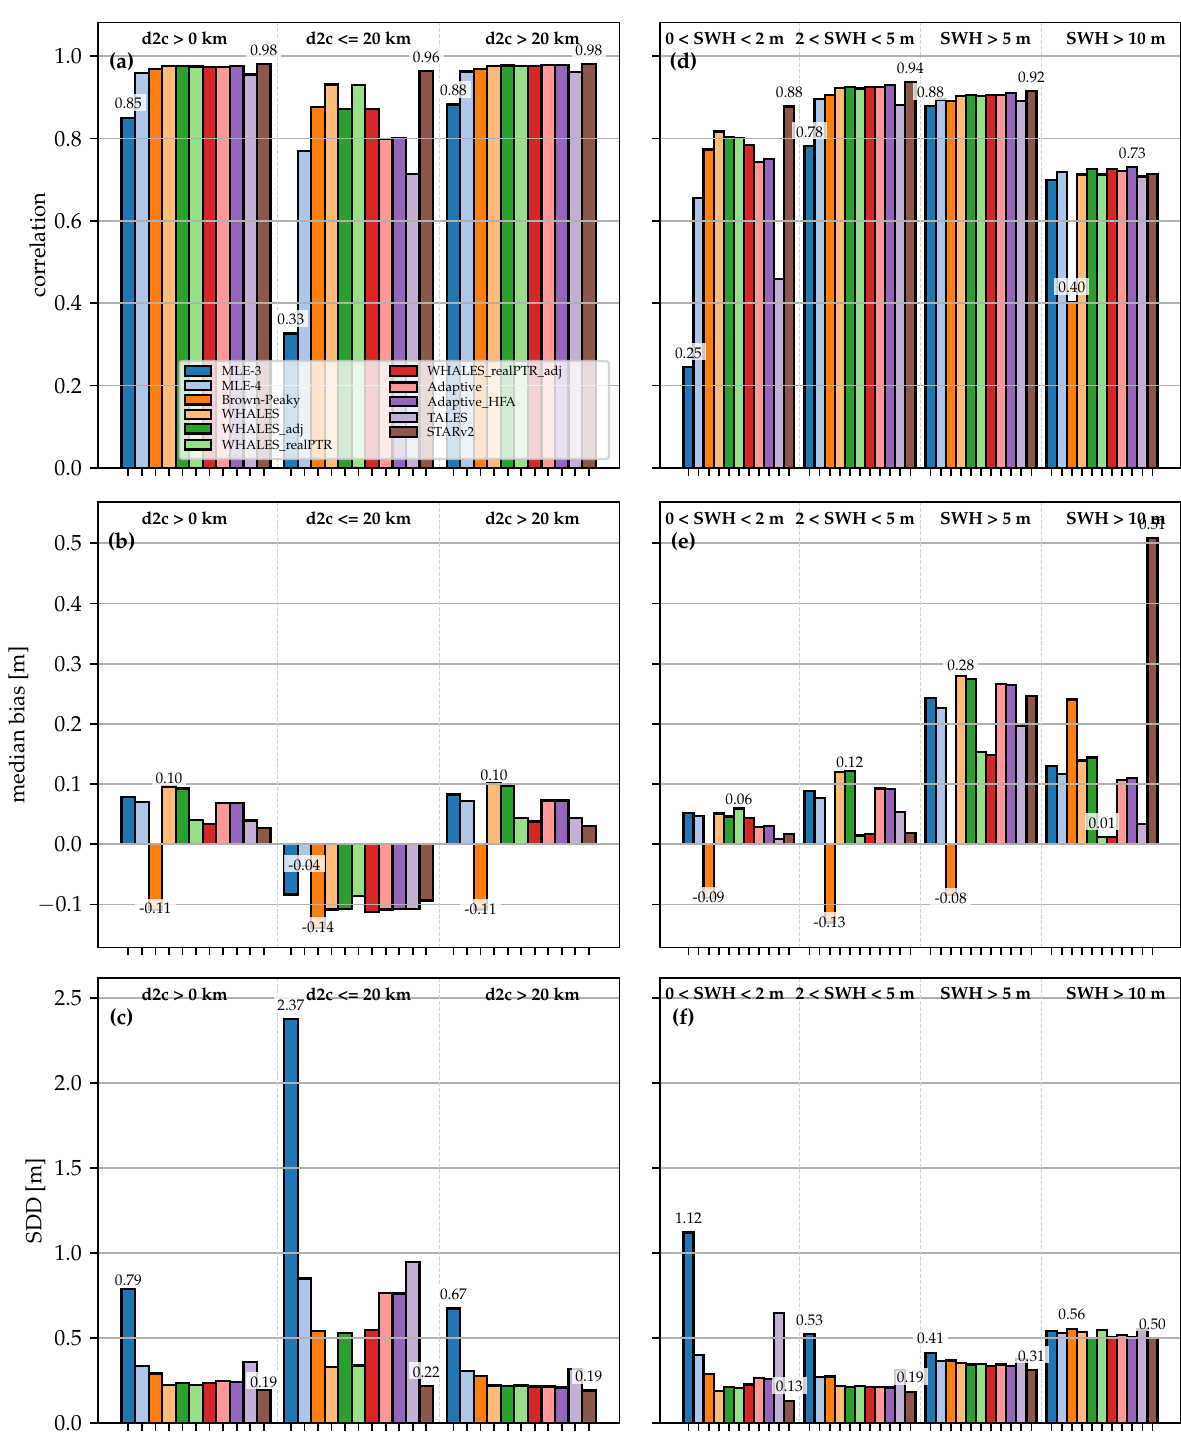
Figure 9. Comparison of the ( a,d ) correlation coefficient, ( b,e ) median bias, ( c,f ) SDD against ERA5-h model of the individual J3 retrackers as a function of distance-to-coast (dist2coast) and of SWH,